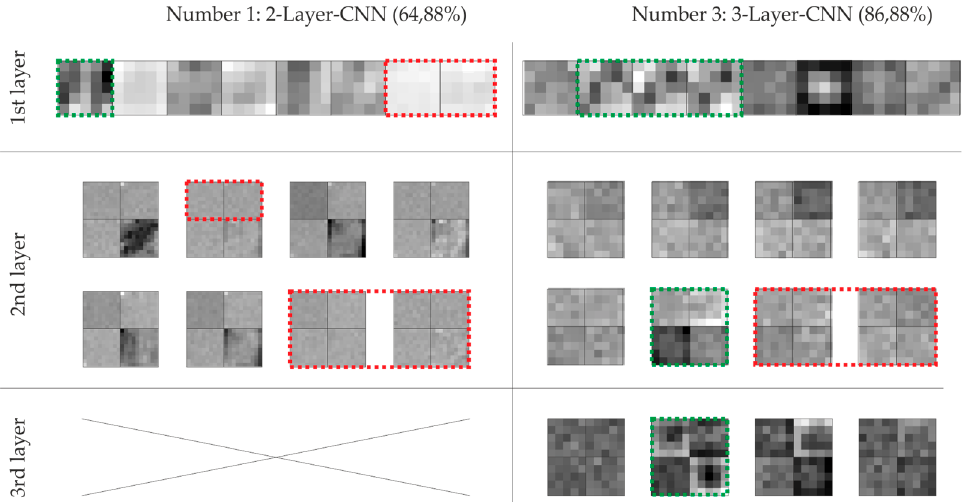
Figure 7. Visualization of CNN weights for CNN architecture 1 ( left ) and 3 ( right ). Eventually untrained weights are marked in red, trained or interesting weights are marked green.